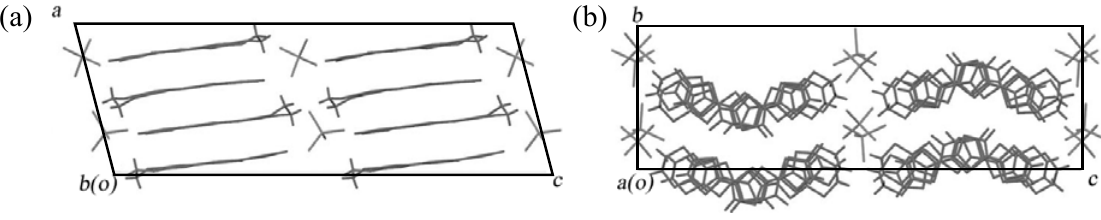
•FeBr •(DCE) (X = Cl, Br) along the (a) 2 4 0.5